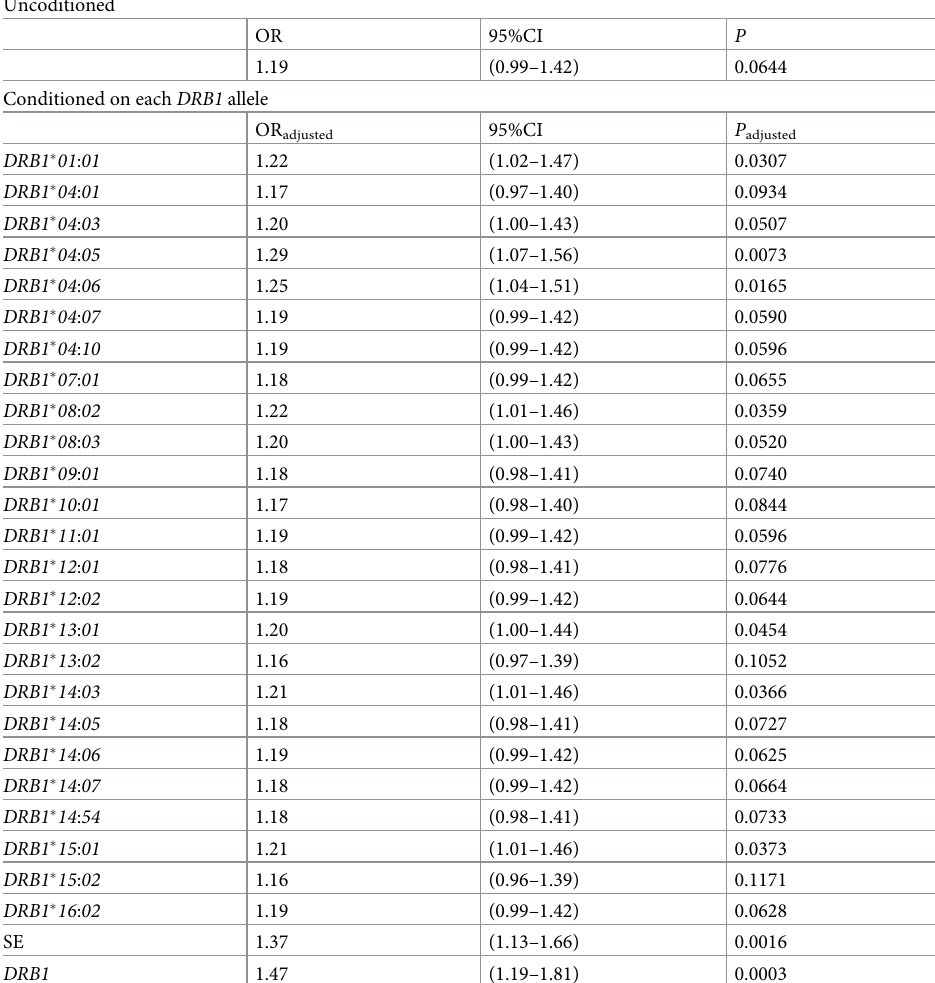
RA: rheumatoid arthritis, ACPA: anti-citrullinated peptide antibody, ACPA(+)RA: ACPA positive RA, OR: odds ratio, CI: confidence interval, SE: Shared epitope. The association of DPB1 (cid:3) 02 : 01 with ACPA(+) RA was analyzed by logistic regression analysis. The first row indicates the results from unconditioned analyses. The other rows indicate the results from analyses conditioned on shown DRB1 alleles. P adjusted and OR adjusted were calculated by conditional logistic regression analysis under the additive